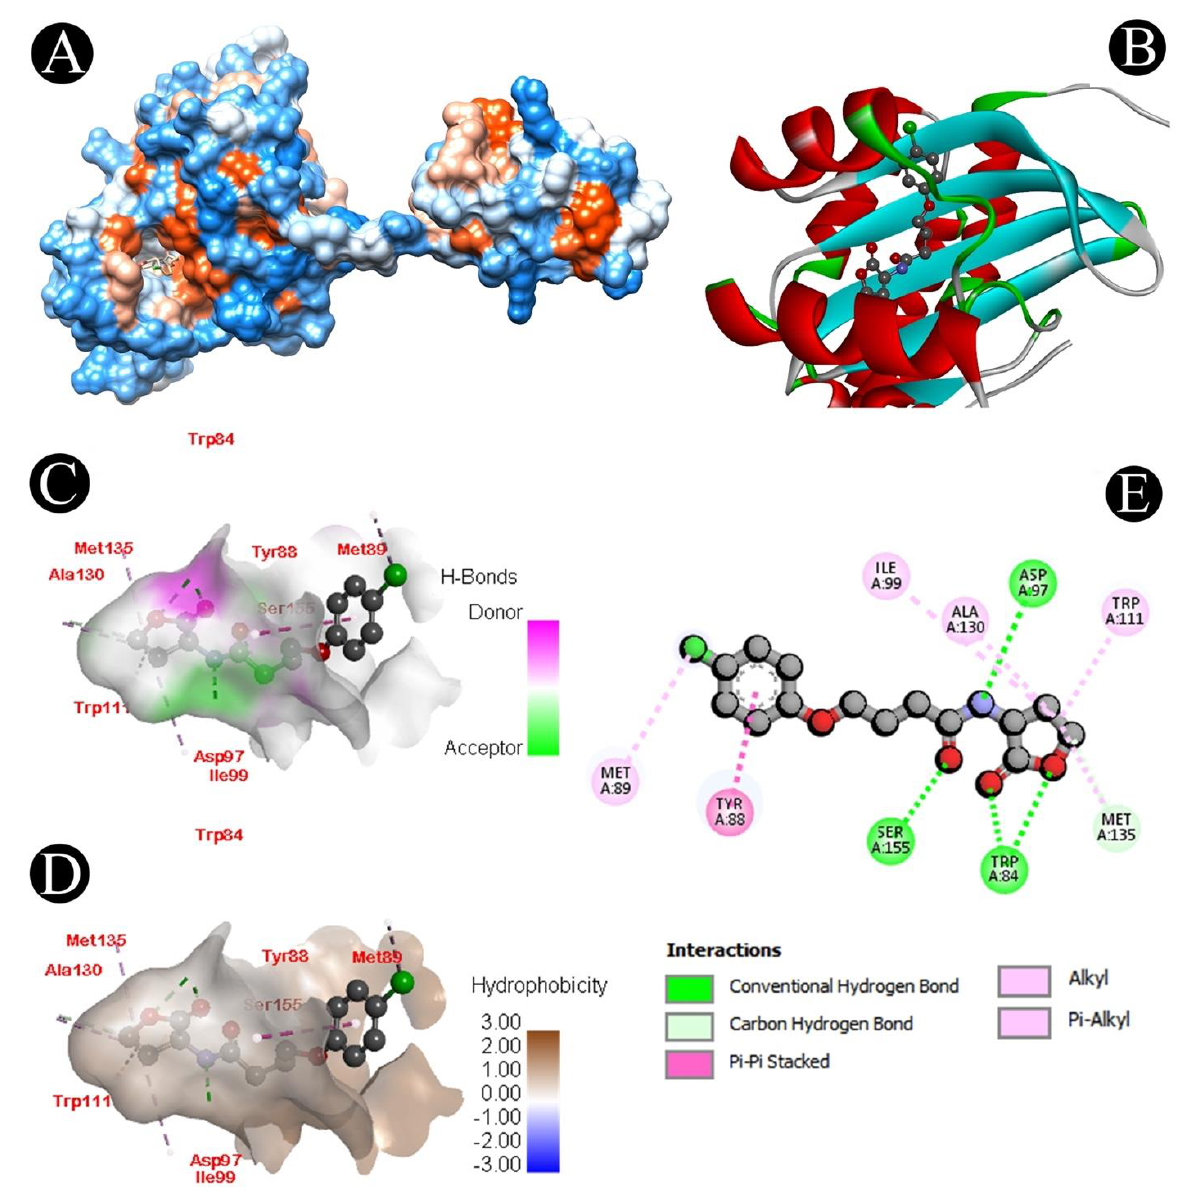
Figure 10. Visualization of the docking analysis of the standard QS inhibitor chlorolactone binding with 3QP5. ( A ) Interaction of chlorolactone with 3QP5. ( B ) Close-up of the interaction of chlorolactone with 3QP5. ( C ) Visualization of hydrogen bond. ( D ) Visualization of hydrophobic interaction. ( E ) Two-dimensional representation describing the bindings of chlorolactone with an active site of 3QP5.